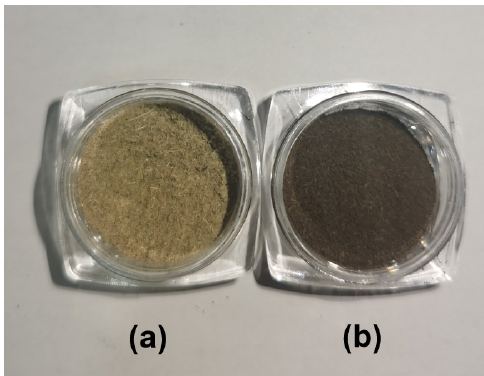
Figure 1. Materials prepared in the laboratory: ( a ) rice straw power; ( b ) rice straw hydrothermal